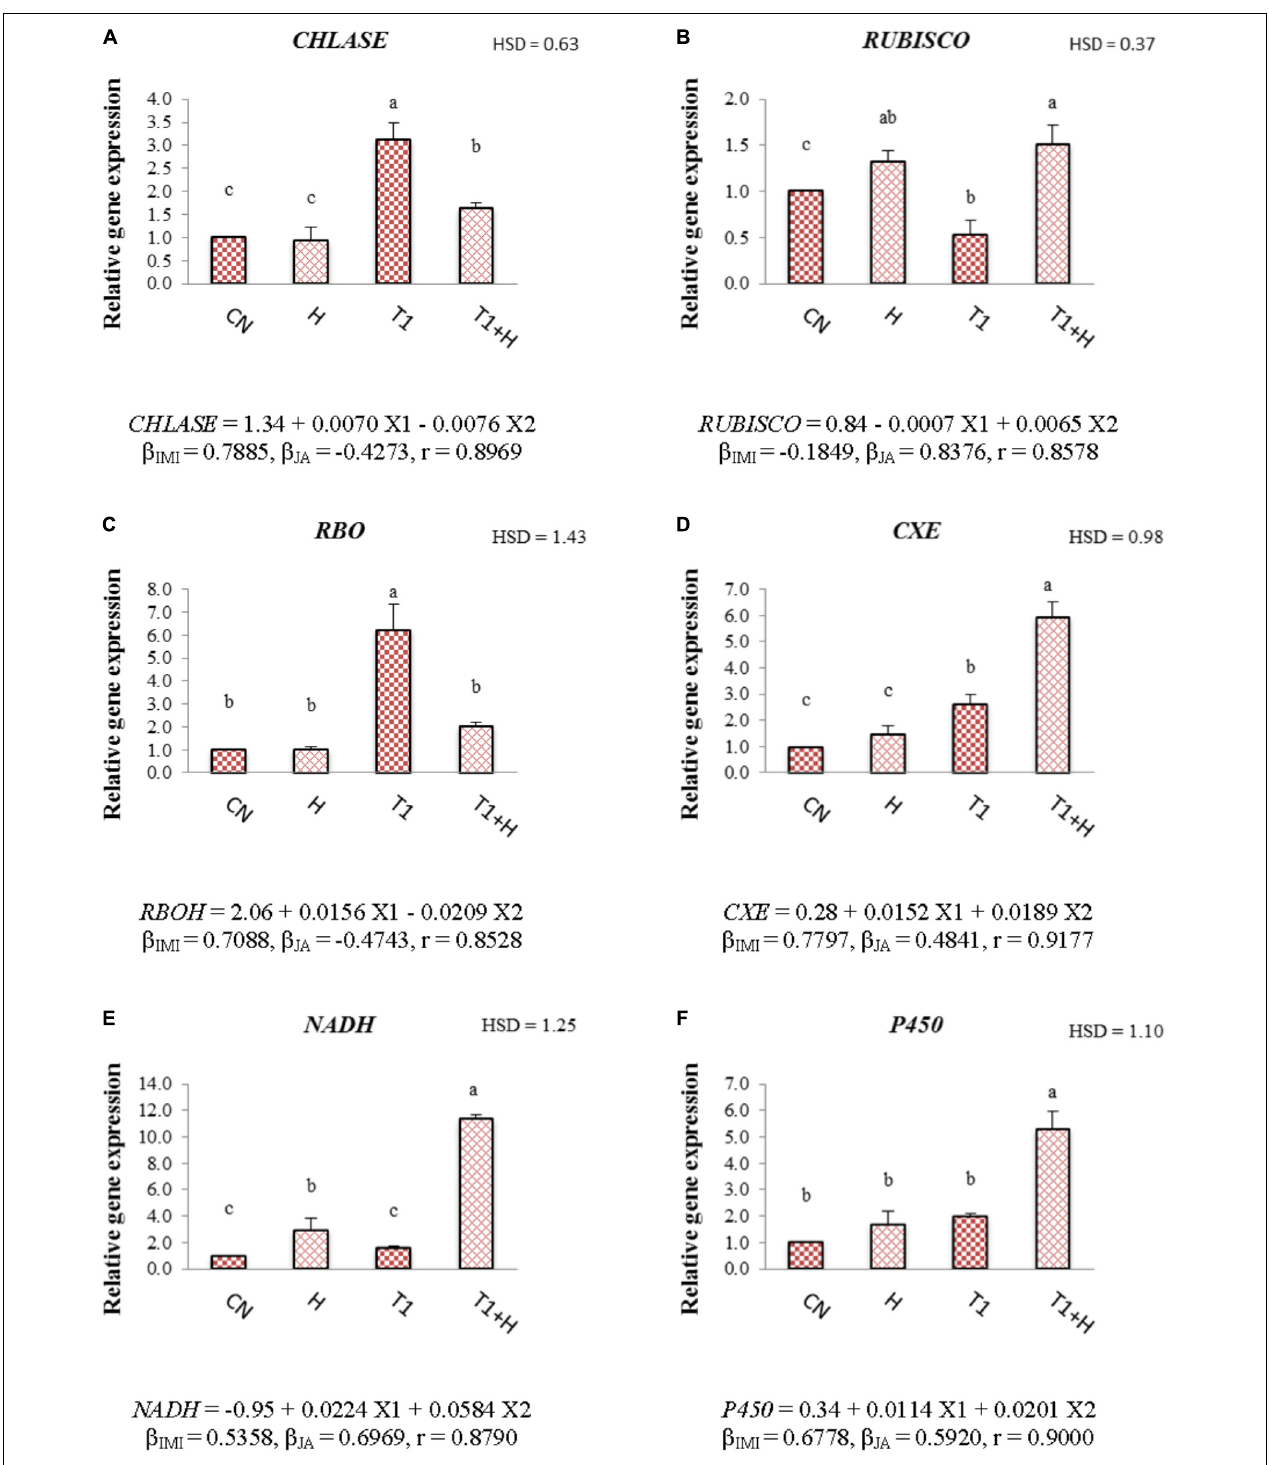
FIGURE 2 | Effect of JA seed soaking on the relative expression of various genes in B. juncea seedlings under IMI stress. Data shown here are mean ± SD ( n = 3). Means with same letters are not significantly different from each other, IMI, imidacloprid (X1); JA, jasmonic acid (X2); T1, 200 mg · L − 1 (IMI); H , 100 nM (JA), r, multiple correlation coefficient. RBO , respiratory burst oxidase; RUBISCO , ribulose-1,5-bisphosphate carboxylase/oxygenase; NADH, NADH-ubiquinone oxidoreductase ; CXE, carboxylesterase; CHLASE , chlorophyllase; P450 , cytochrome P450 monooxygenase. β = β -regression coefficient. A = CHLASE ; B = RUBISCO ; C = RBO ; D = CXE ; E = NADH ; F = P450